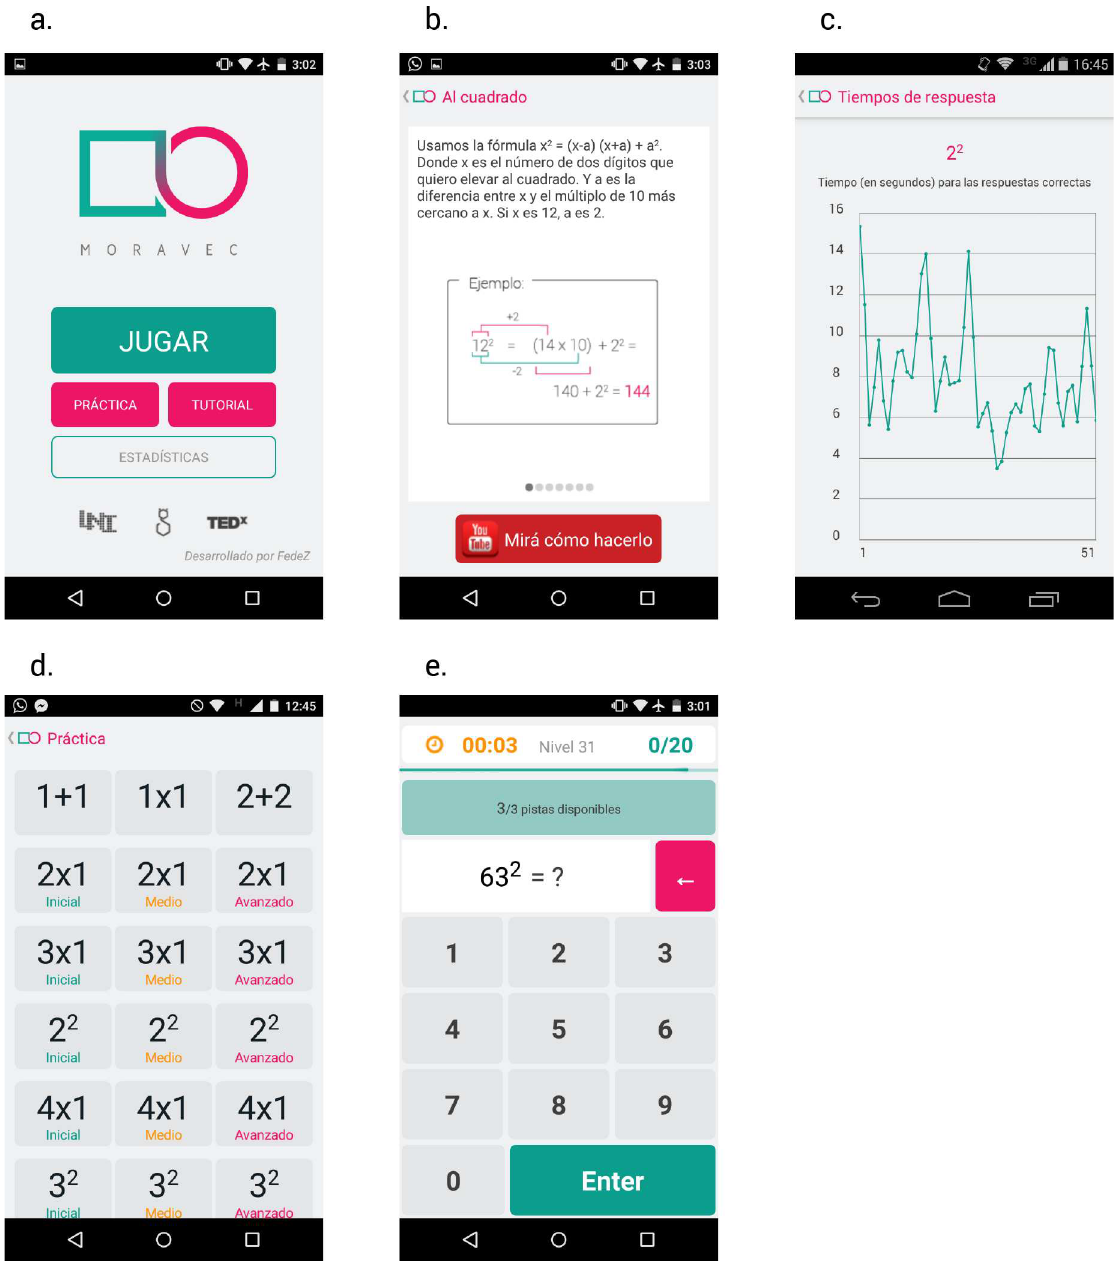
Fig 1. Some Moravec screenshots. (a) Initial screen with the logo and four buttons: Play (“Jugar”), Practice (“Pra´ctica”), Tutorial and Statistics (“Estadisticas”). (b) One of the many tutorial screens explainingthe algorithms and with a link to a youtubetutorial video. (c) One of the statistics shown. It plots RTs as a function of the trial numberfor 2-digits square operations. (d) In the “Practice” section the user can choose which operationto train. For each operationthree difficulty levels can be chosen: initial, medium and advanced.In the advancepractice, problemsare shown for 5 secondsand then disappear whilein the other cases its remainsvisible until the user press enter (see